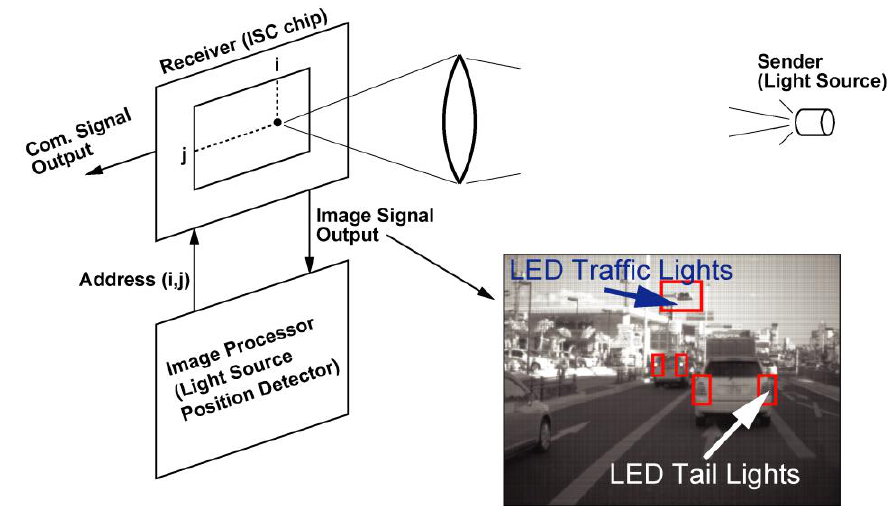
Figure 1. Image-Sensor-Based Optical Communication System.